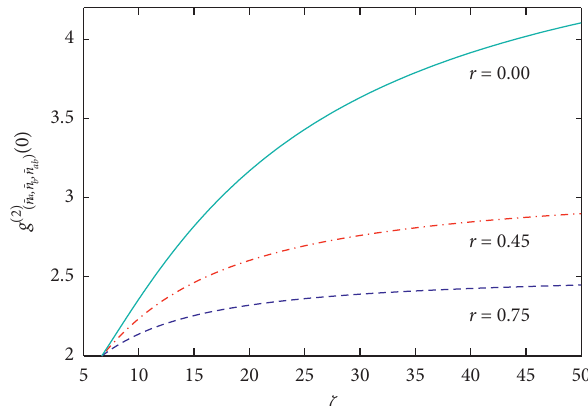
Figure 9: Plots of the steady state photon number correlation (equation (62)) versus ζ for κ � 0 . 8, ε � 0 . 20, and A � 2 . 50 and for different values of r